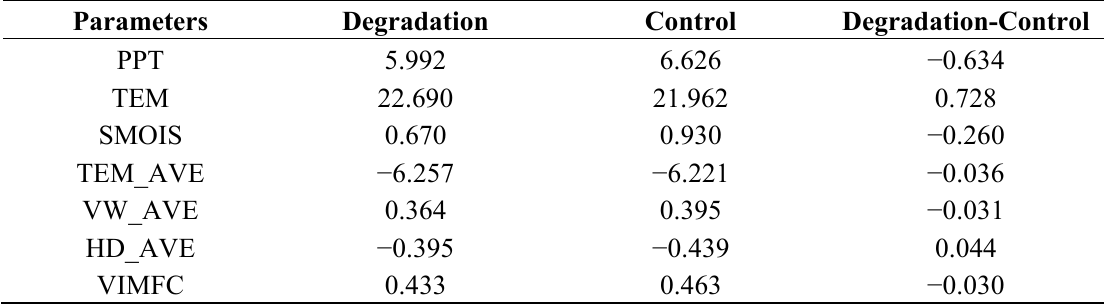
Table 4. Simulated ensemble JJA mean of atmospheric variables for degradation and control experiments and the differences between them over 24.5°–29° N, 103.5°–109.5° E. Parameters Degradation